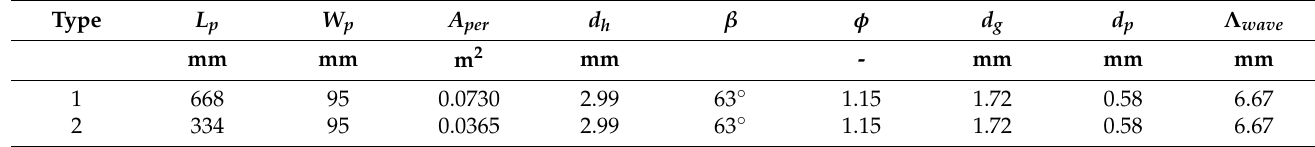
Table 3. Geometrical parameters of the